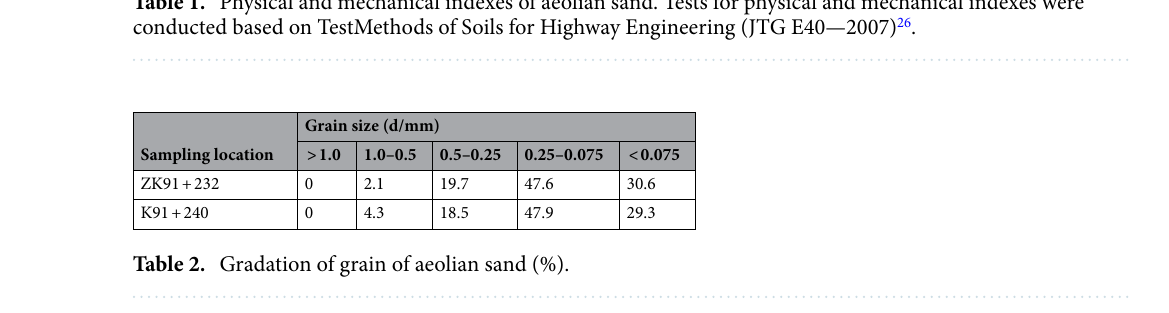
Table 1. Physical and mechanical indexes of aeolian sand. Tests for physical and mechanical indexes were conducted based on TestMethods of Soils for Highway Engineering (JTG E40—2007) 26 .